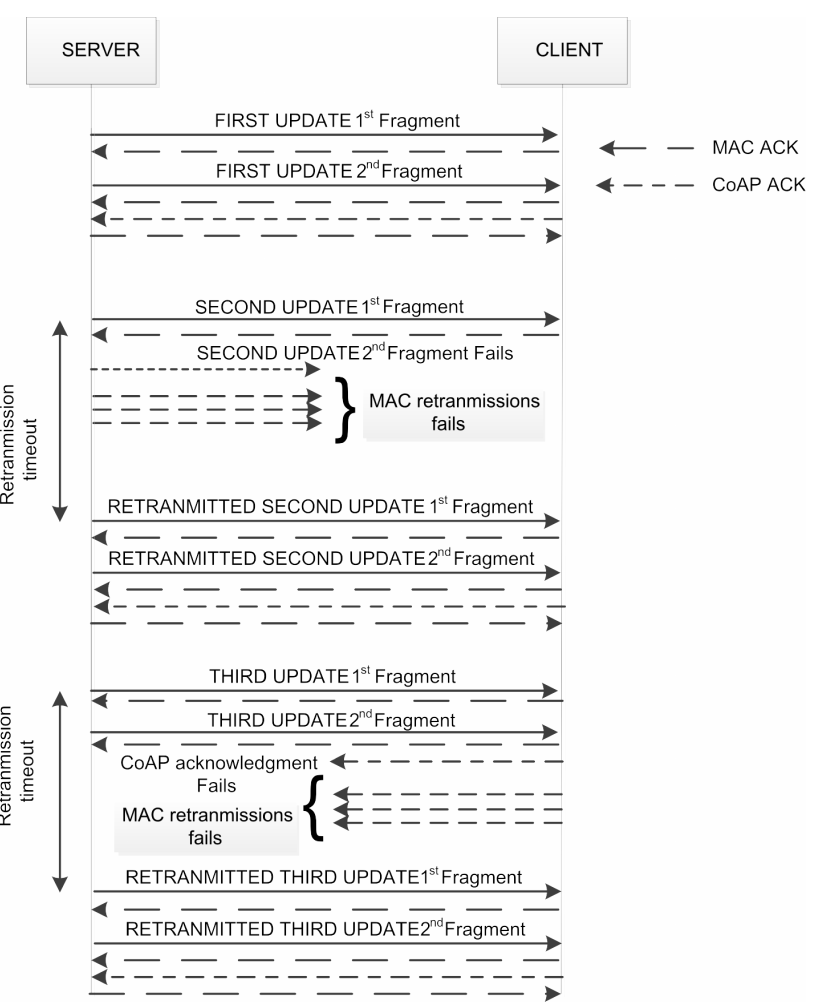
Figure 2. Each update is composed by two fragments. The client fails to send the CoAP ACK at the third update while a fragment transmission fails in the second one. Both failures cause the retransmission of the entire fragmented